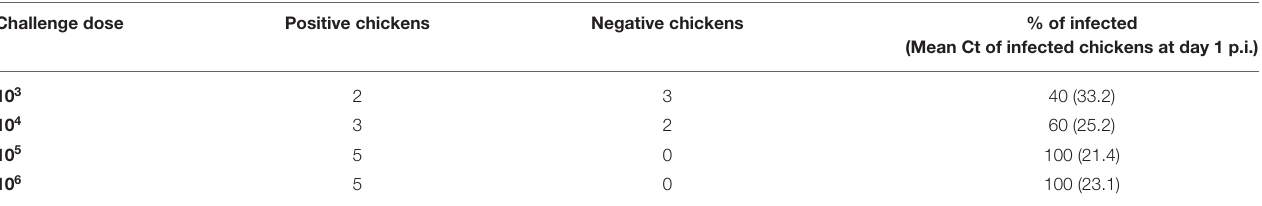
(Mean Ct of infected chickens at day 1